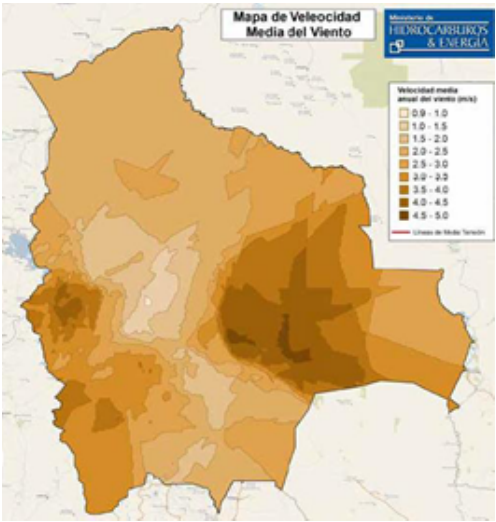
Figure 8. Average wind speeds